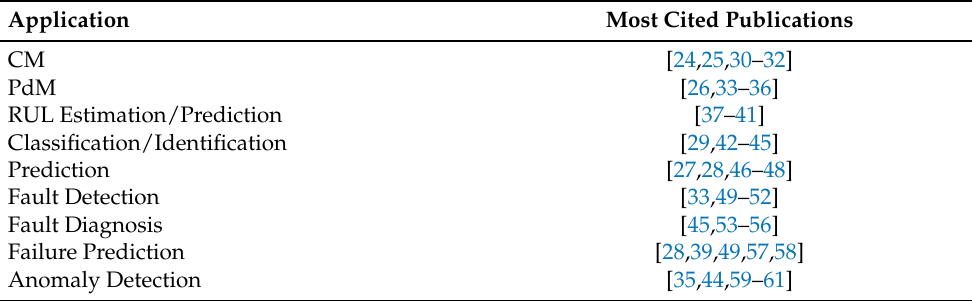
Table 5. The respective five most cited publications in each field of